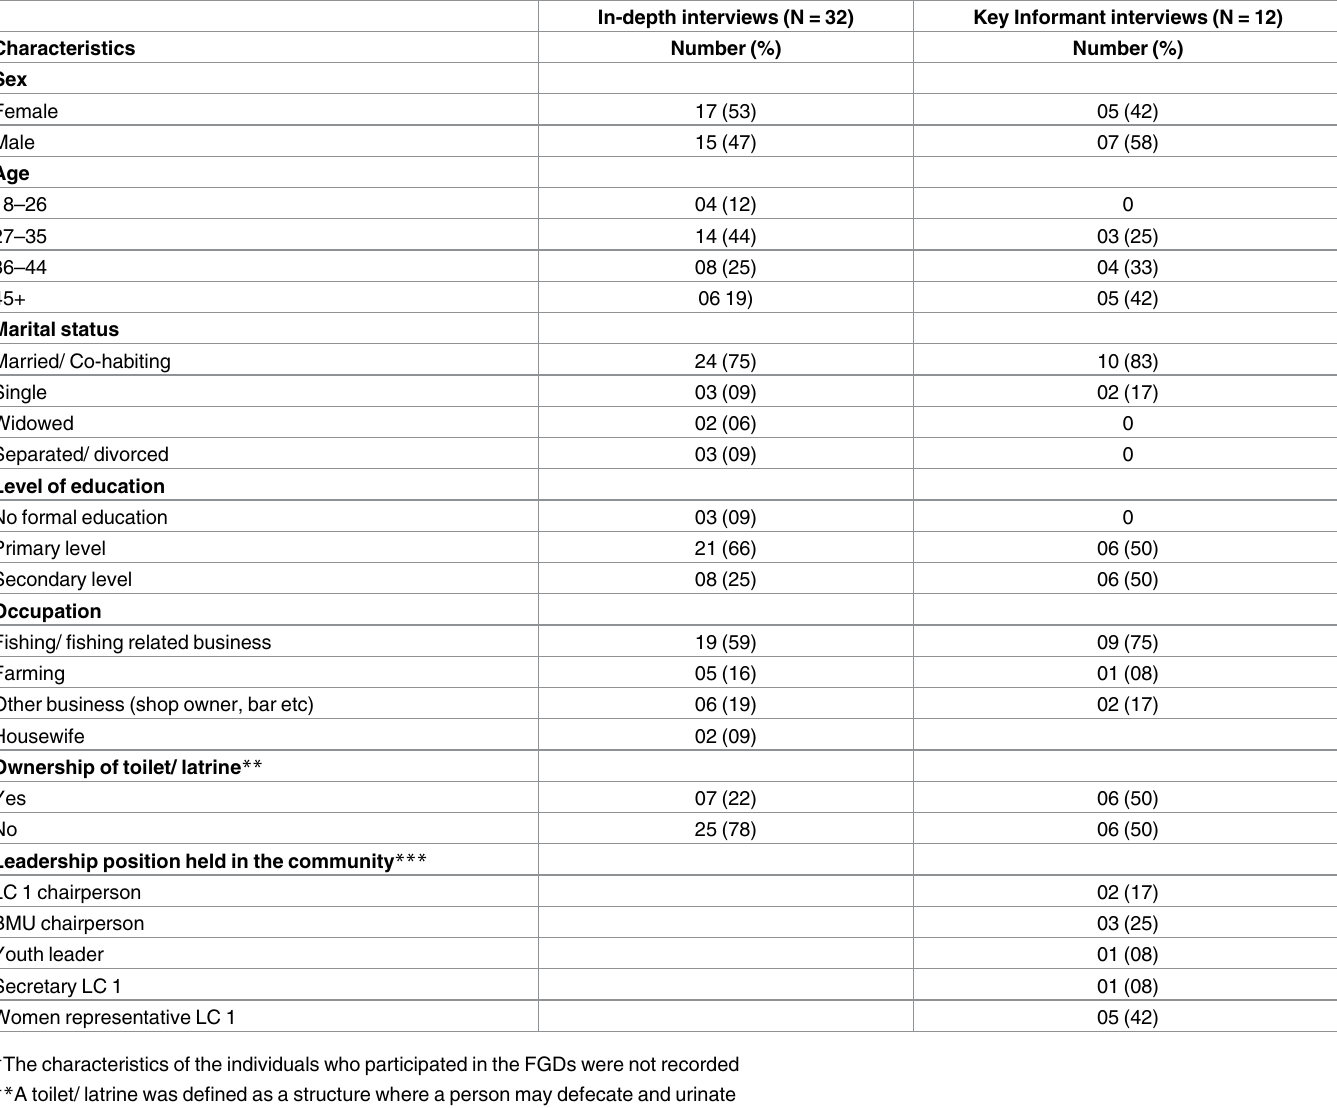
Table 1. Socio-demographic characteristics of the study participants *